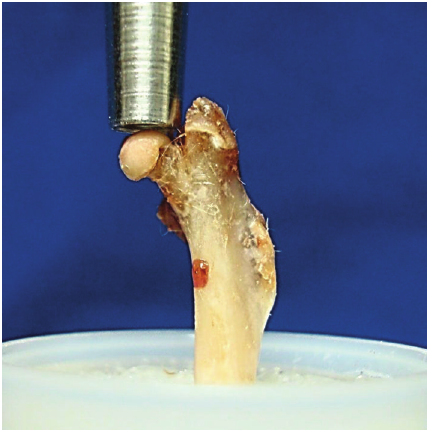
Figure 2: Biomechanical test